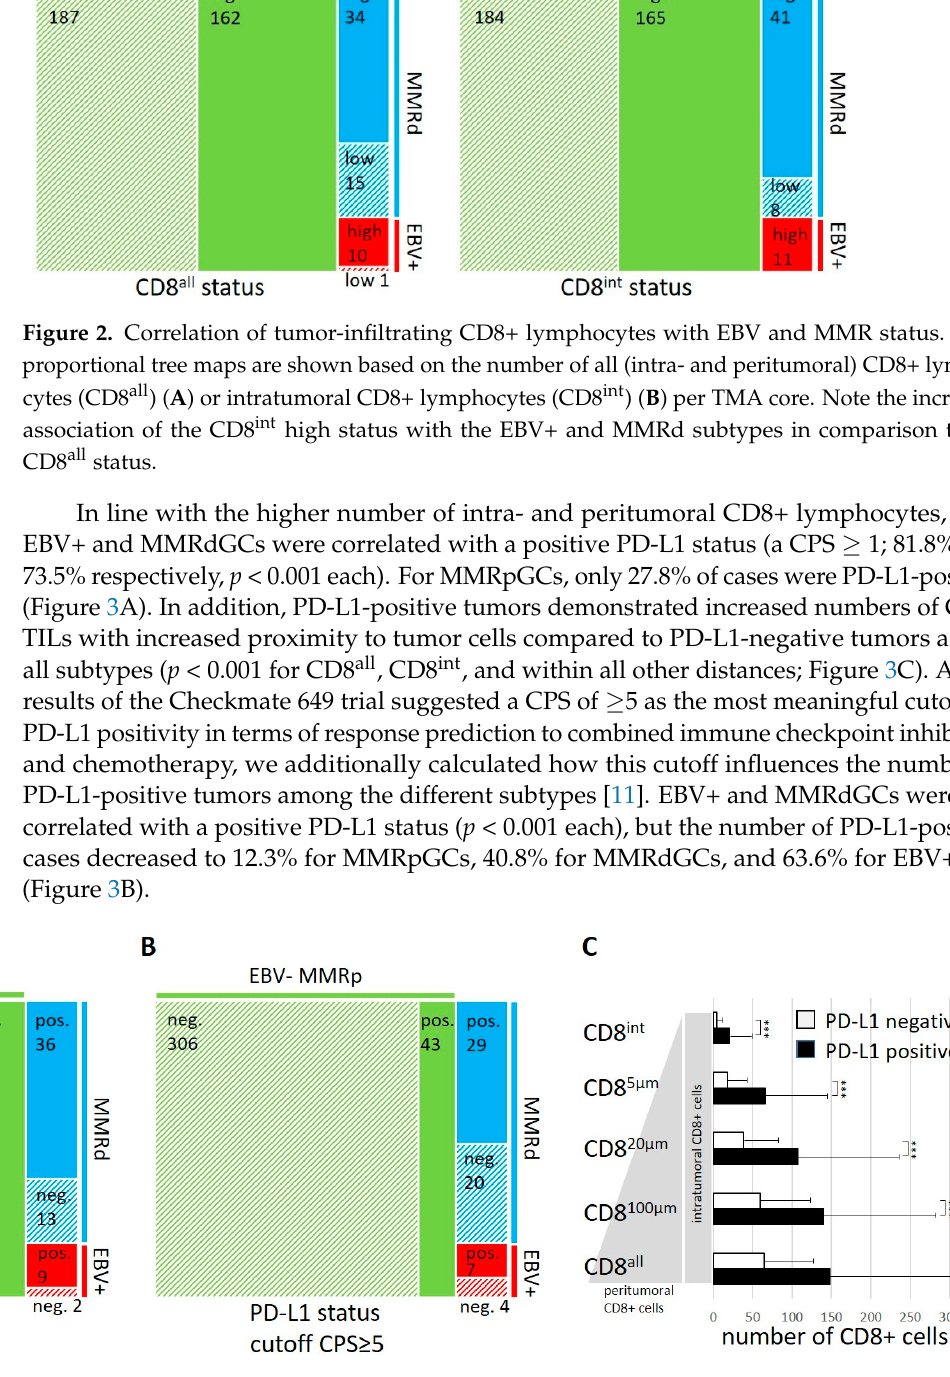
Figure 3. Correlation of PD-L1 expression with EBV and MMR status and tumor-infiltrating lymphocytes. An area proportional tree map is shown based on the PD-L1 status using a CPS ≥ 1 ( A ) or CPS ≥ 5 ( B ) as a cutoff. A bar graph demonstrates the association of a positive PD-L1 status (a CPS ≥ 1) with increased numbers of intratumoral and peritumoral CD8+ lymphocytes ( C ). *** refers to p ≤